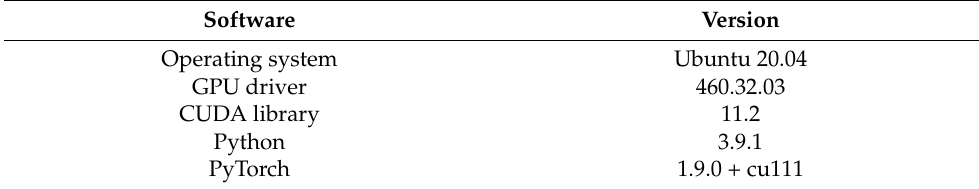
Table 2. Software configuration.